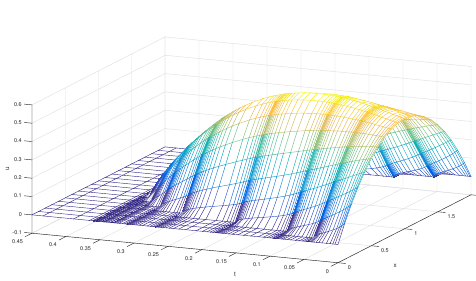
Fig. 1: Evolution of the maximal solution of Eq. (1) .